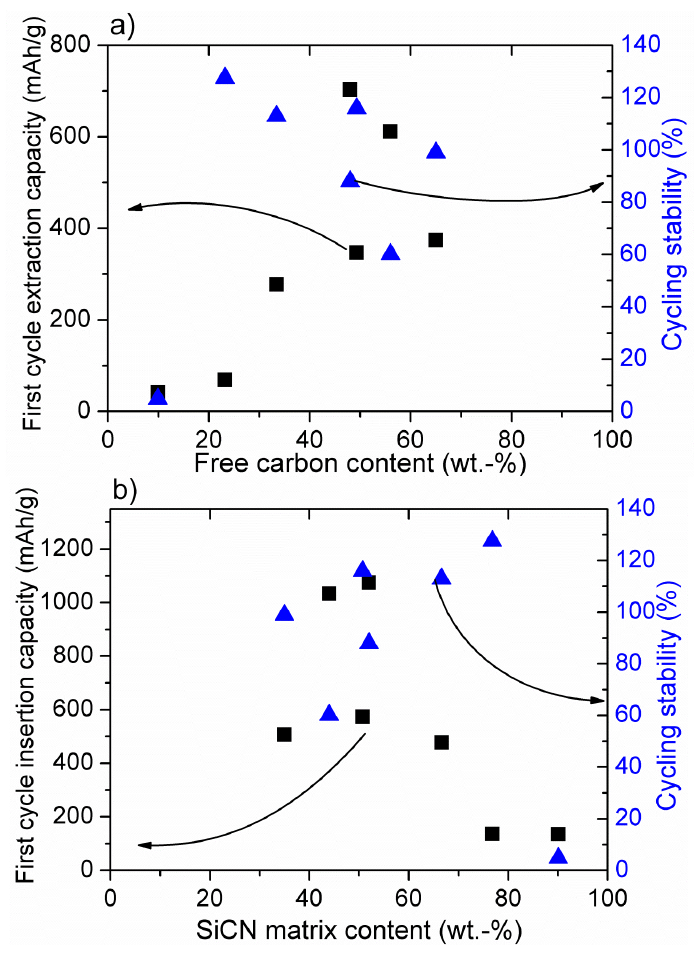
Figure 2. Dependence of the insertion and extraction capacity of SiCN-derived materials on the amount of free carbon ( a ) and SiOC matrix ( b ). Cycling stability defined as the ratio of the extraction capacity after prolonged cycling (>100 cycles) to the first extraction capacity. Experimental data for samples pyrolysed at 1000–1100 °C from